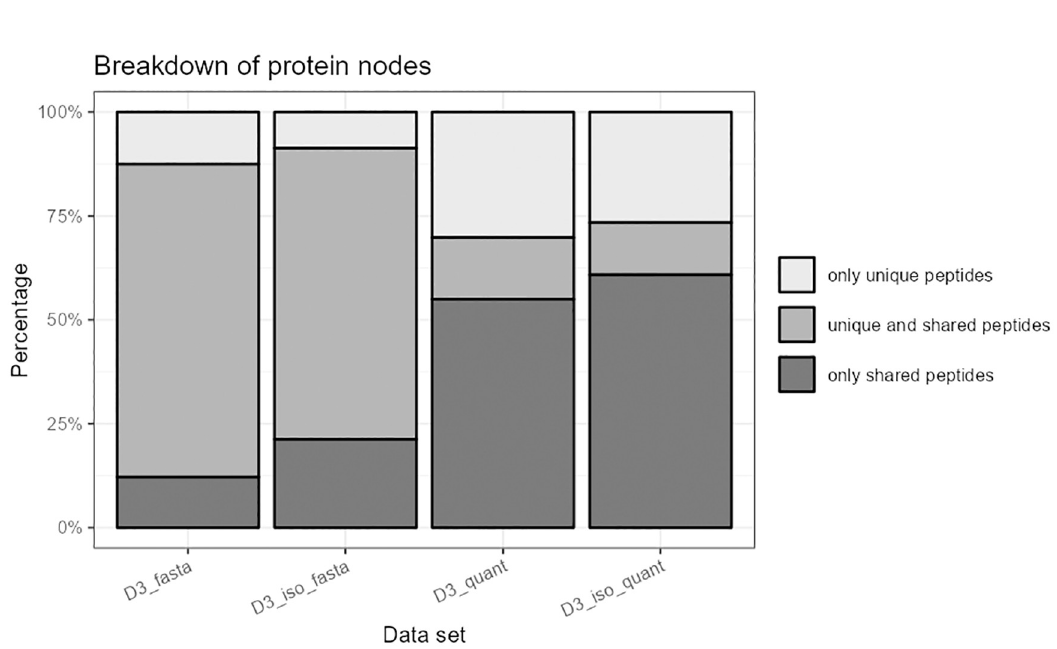
Fig 4. Distribution of protein node types with and without the inclusion of isoforms. Percentages of protein nodes with only unique peptides vs. unique and shared peptides vs. only shared peptides for data set D3, with and without isoforms. Please note: As described in the ‘Methods’ section, peptide nodes may contain multiple peptide sequences and protein nodes may contain multiple protein